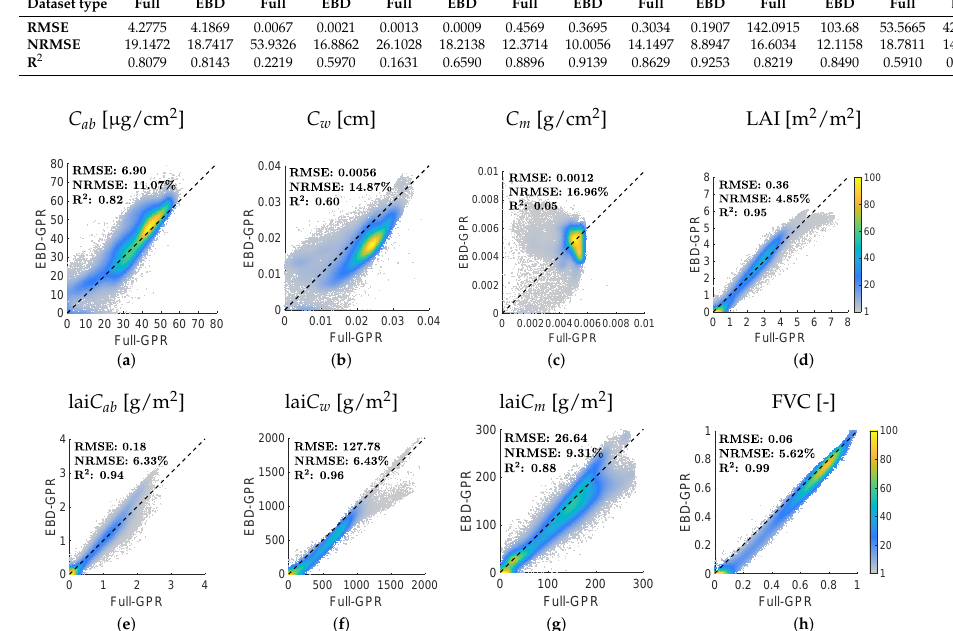
Figure 5. Density scatterplots for comparison of crop trait maps estimated by a full GPR model (not shown) and the EBD-GPR model: C ab ( a ), C w ( b ), C m ( c ), LAI ( d ), lai C ab ( e ), lai C w ( f ), lai C m ( g ), and FVC ( h ). Density in